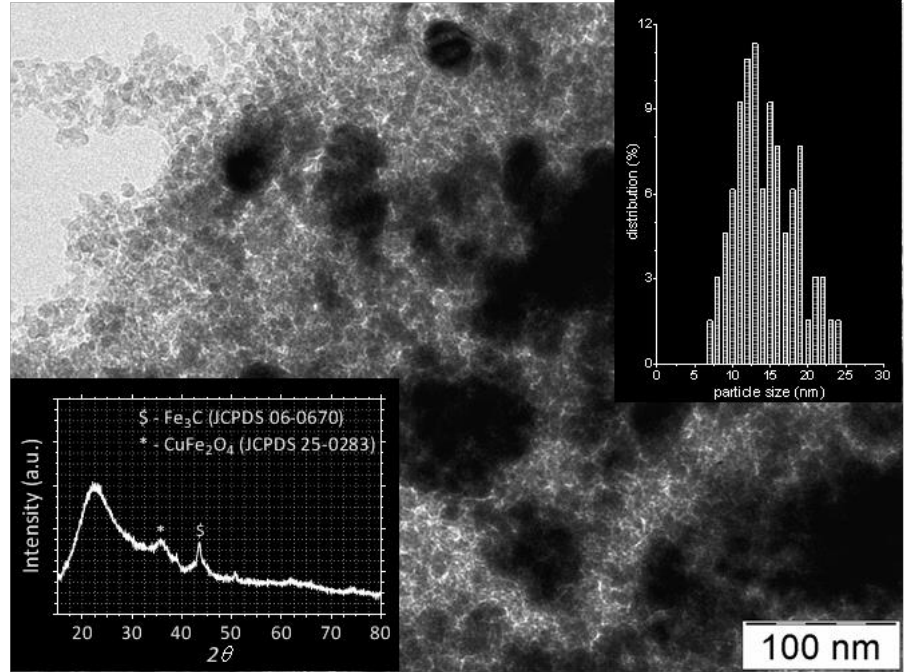
Figure 10. TEM image of the Cu(3)Fe(7)-Si sample after run ( P R , 30 bar; T R , 260 °C; GHSV: 8800 N L/kg cat /h; tos, 5400 min).